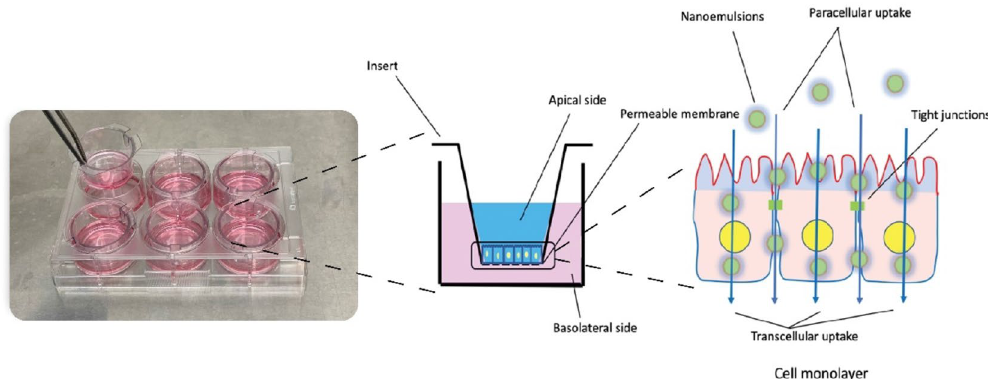
Figure 2. Transepithelial transport study of nanoemulsions using Caco-2 cells